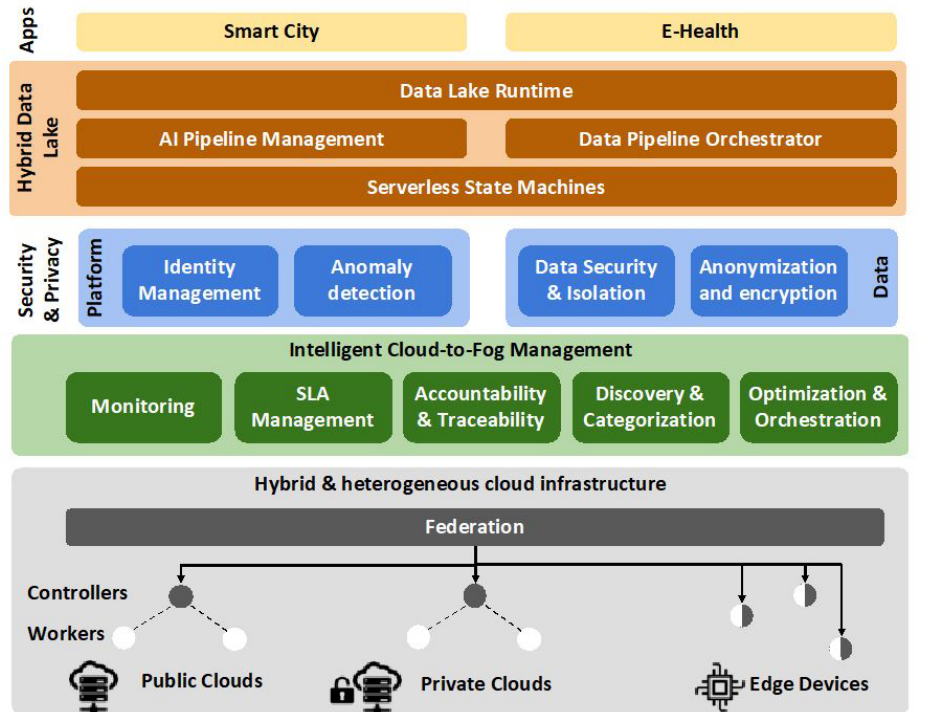
Figure 3. Architecture diagram and building blocks of the proposed PaaS